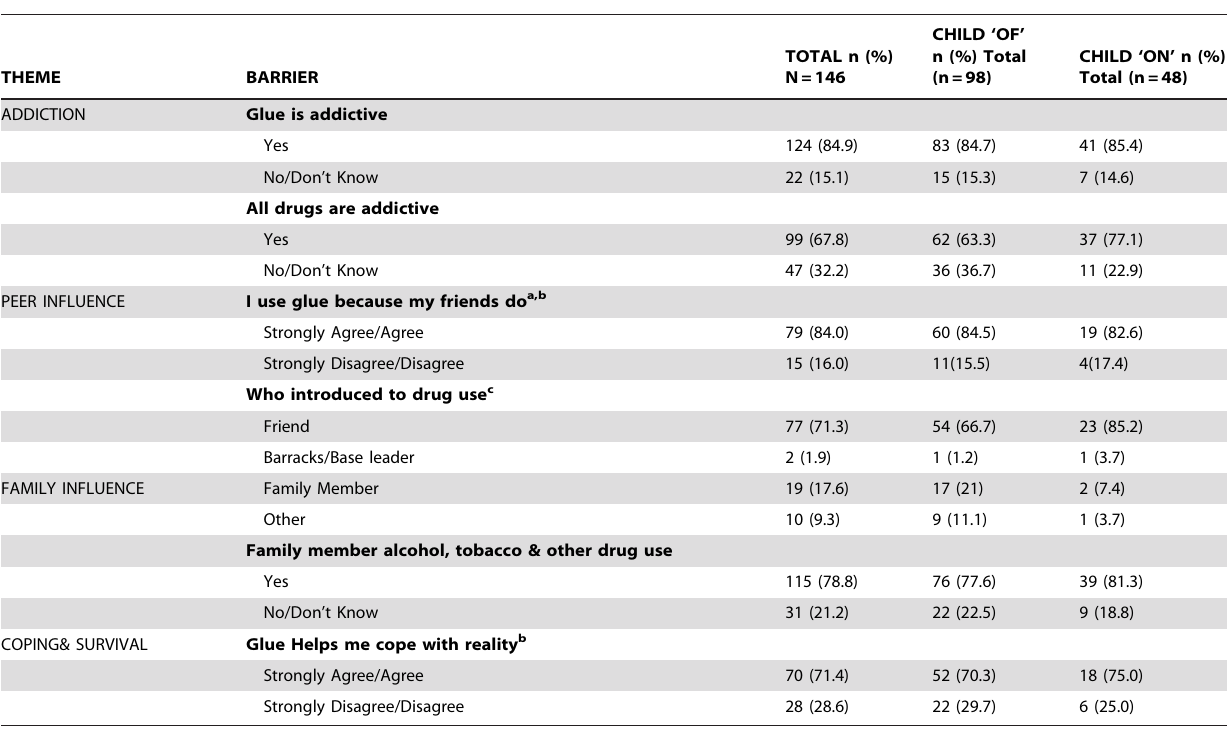
Table 2. Barriers to drug cessation among 146 street-involved children and youth in Eldoret, Kenya.